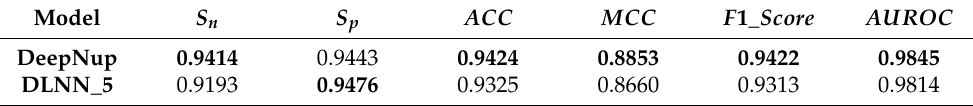
Table 7. Comparison of DeepNup with DLNN_5 via 10-fold cross validation on the DatasetNup_3